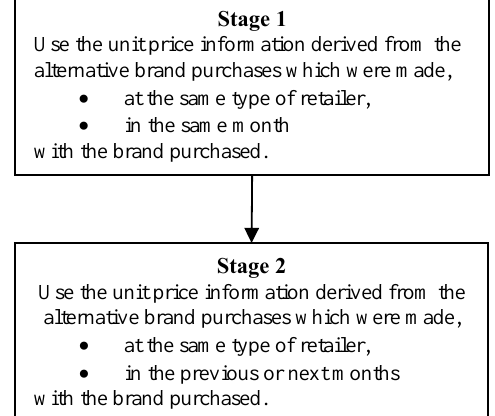
Figure 3 A two staged method of price data generation for the brands that are not